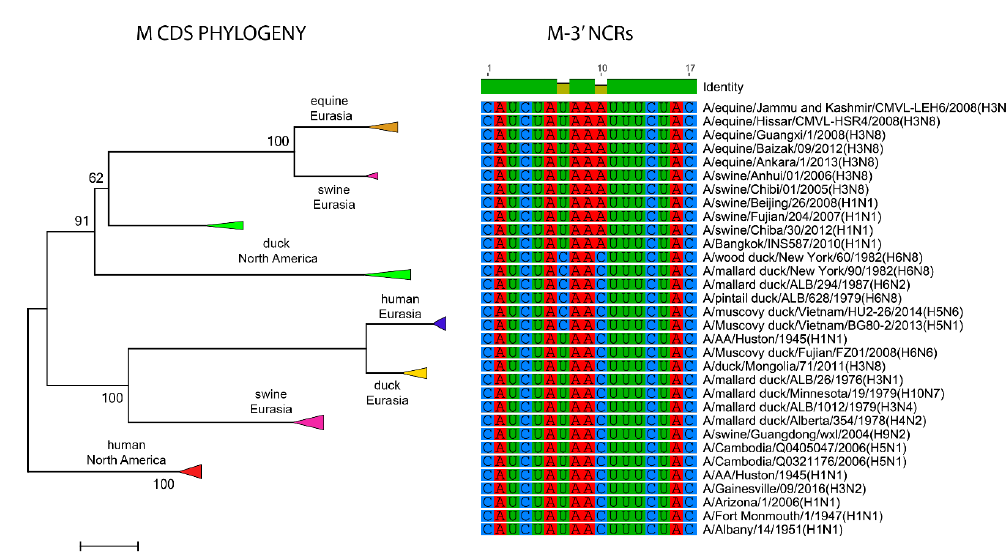
Figure 9. Relationships among M 3 ′ NCR and CDS regions for viruses from different host species and geographic locations. Alignments of the 3 ′ NCRs, shown corresponding to the genomic RNAs, from the viruses used in the analyses are next to the CDS-based neighbor-joining tree for these viruses.